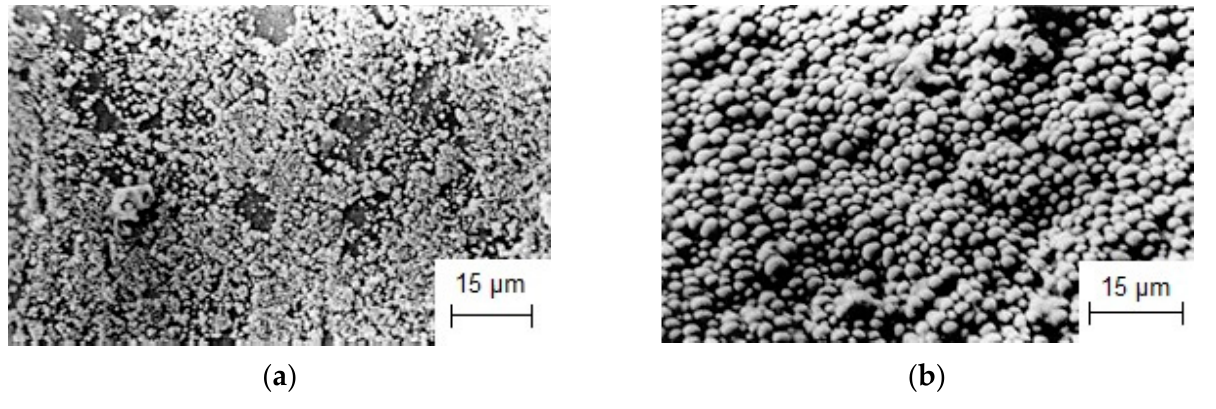
Figure 7. St.3 substrate surface morphology after its ( a )—3 h exposure and ( b )–8 h exposure in the NaCl-KCl-K 2 NbF 7 (30 wt.%)—Nb melt at 1173 K.